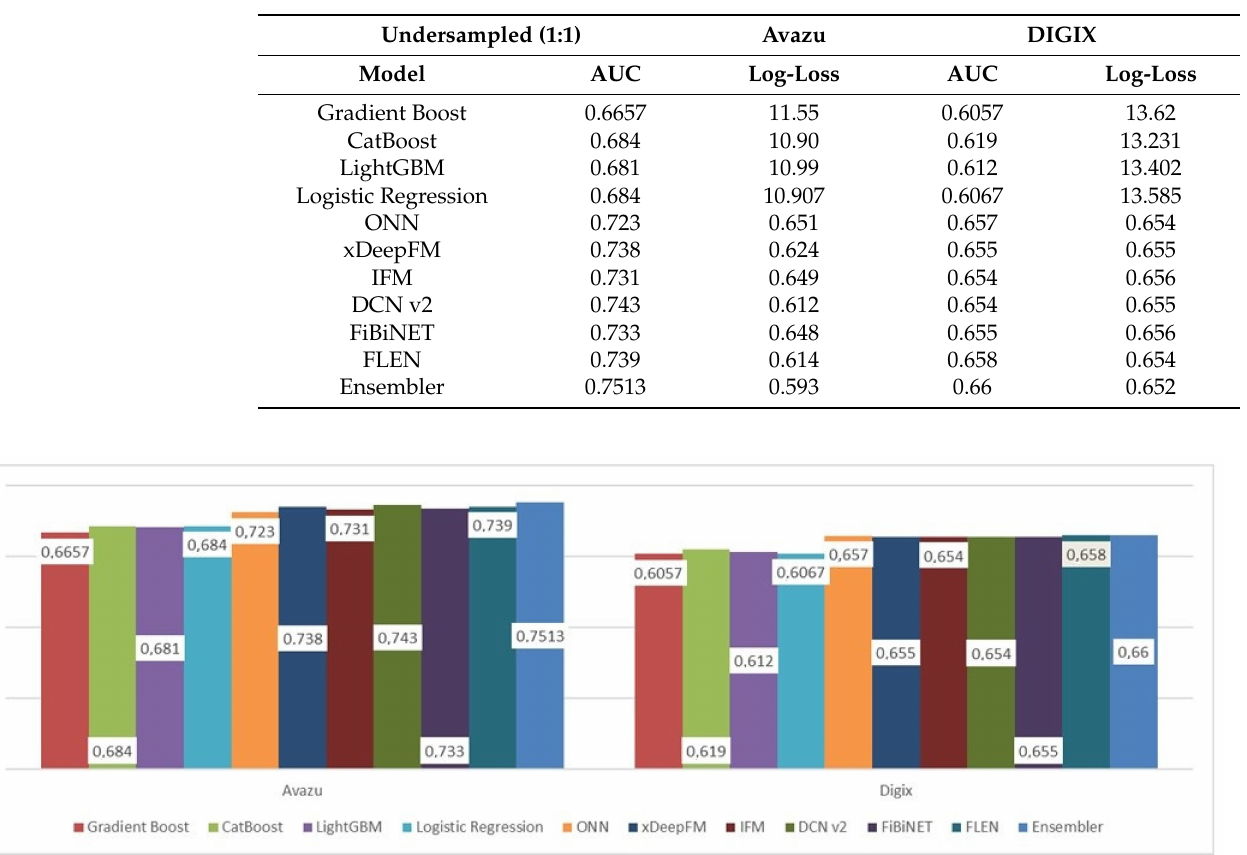
Table 2. Model performances for the balanced undersampled Avazu and Digix dataset.